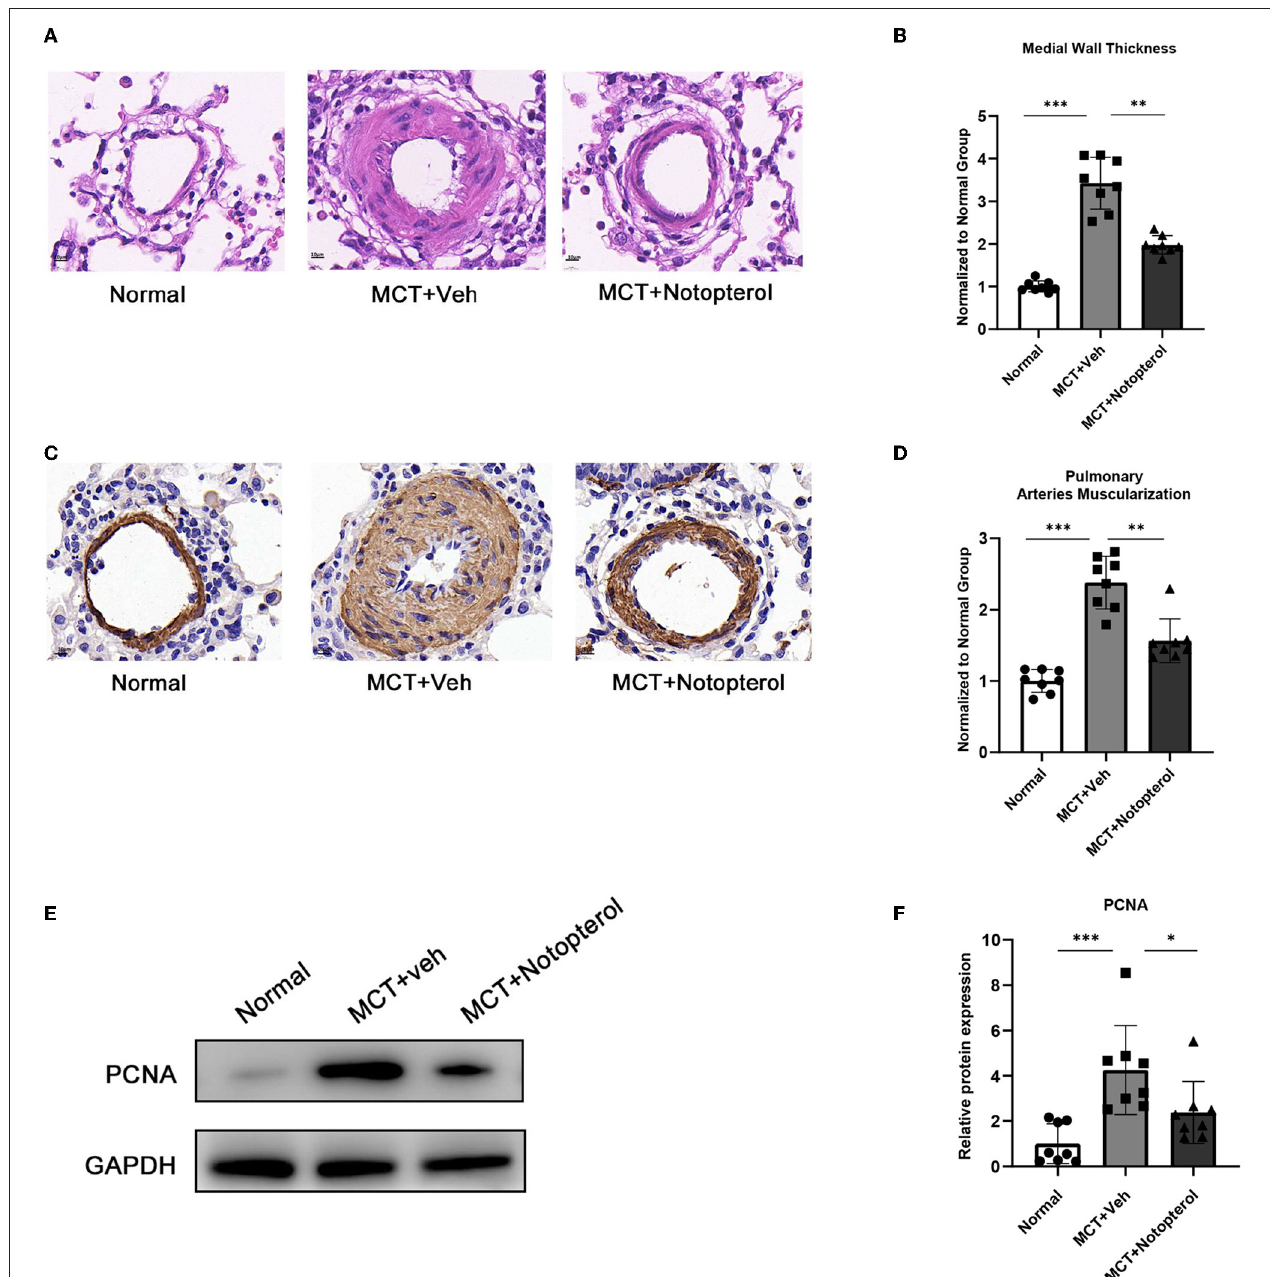
FIGURE 4 | Notopterol eases pulmonary vascular remodeling. (A) Representative H&E staining micrograph of lung tissue sections (100 × ); (B) Quantification of the medial wall thickness of the small pulmonary arteries ( n = 8 for each group); (C) Expression of α -SMA in lungs evaluated with immunohistochemistry staining (100 × ); (D) Quantification of the arteries muscularization of the small pulmonary arteries ( n = 8 for each group); (E) Western blots of PCNA in lungs; (F) Quantification of PCNA expression in the lungs. ( n = 4 for each group). * p < 0.05, ** p < 0.01, *** p < 0.001. H&E, hematoxylin-eosin; α -SMA, α -smooth muscle actin; PCNA, proliferating cell nuclear